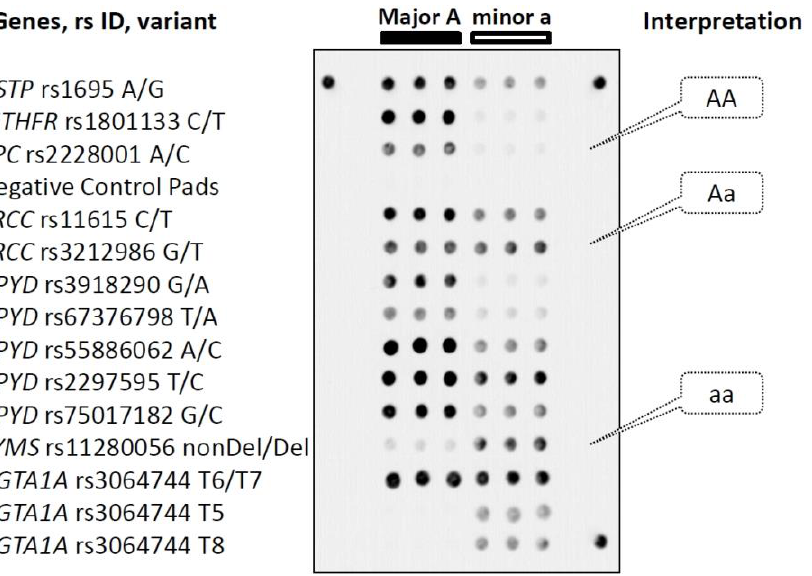
Figure 1. Layout of the genotyping microarray and an example of interpretation of hybridization images. Every horizontal row of gel elements corresponds to the gene variant indicated on the left. Each gel pad harboring a unique interrogating oligonucleotide probe is in triplicate. Gel elements corresponding to the major (A) and minor (a) alleles are arranged in triple left and right columns, respectively. Illustration of identification of homo- and heterozygote genotypes is in the right callouts. Three peripheral gel spots are positioning markers. See the text for details.